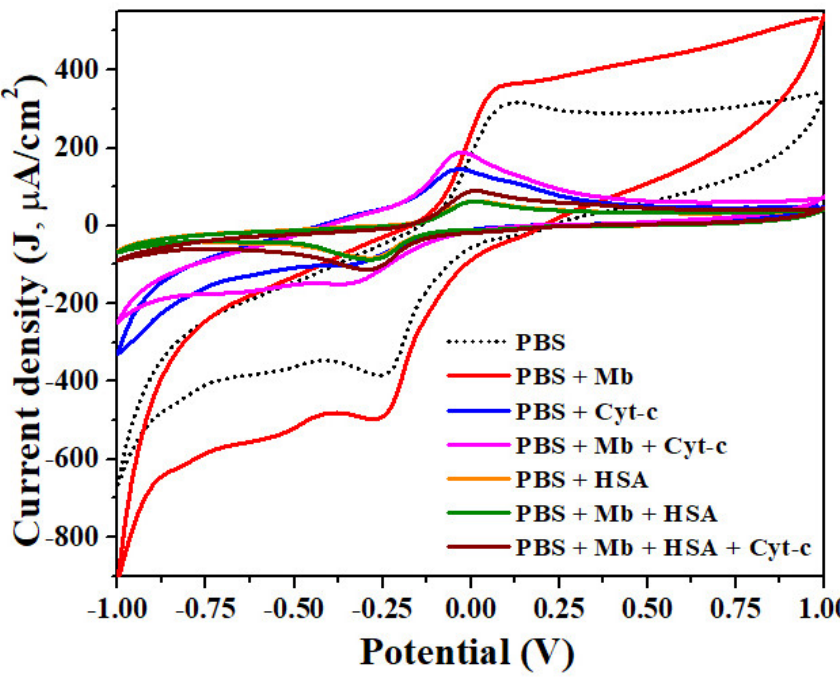
Figure 6. Interference study with Cyt-cand HSA for the fabricated sensor.